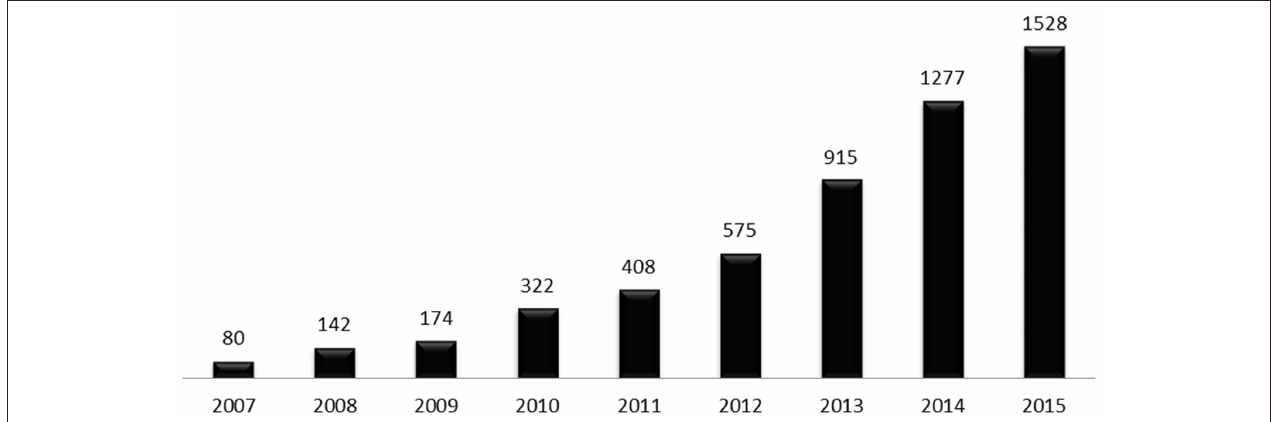
FIGURE 1 | Number of publications related to the human gut microbiota in the last decade, per year. Data were obtained by searching Pubmed (http://www.ncbi.nlm.nih.gov/pubmed/) database using the term “human gut microbiota” on 4th November 2016.